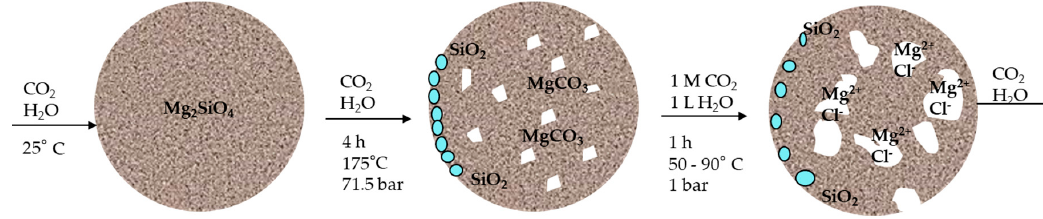
Figure 15. Mechanism of carbonation of olivine with a subsequent leaching with